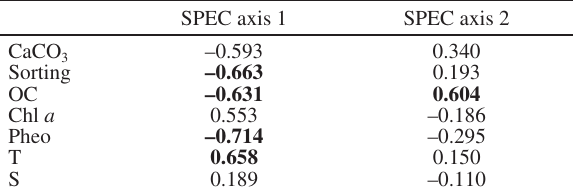
Table 4. – CCA analysis: species-environmental variables correla- tions on axes 1 and 2, highlighting the significant correlations ac- cording to the Monte Carlo permutational